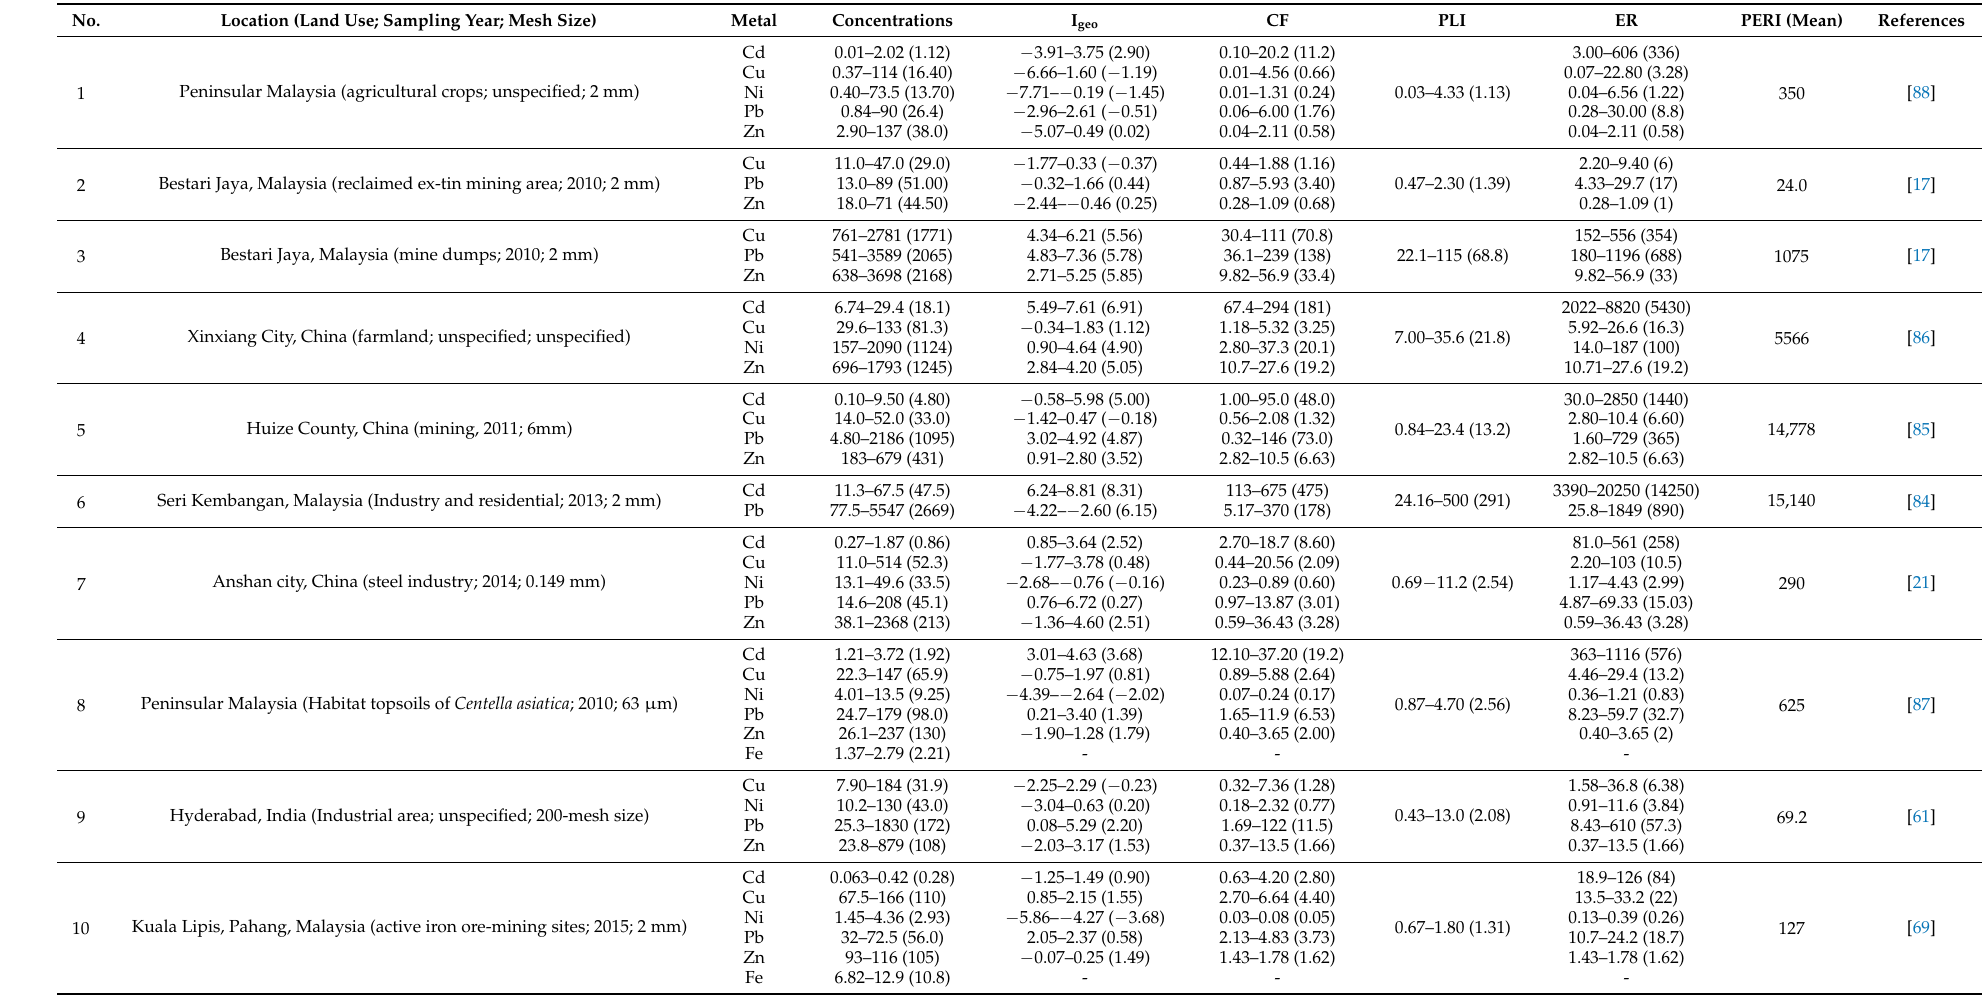
Table 6. Comparisons of values (minimum- maximum (mean)) of potential toxic metals concentrations (mg/kg dry weight), geoaccumulation index (I geo ), contamination factor (CF), pollution load index (PLI), and ecological risk (ER) values of topsoils between reported studies and the present